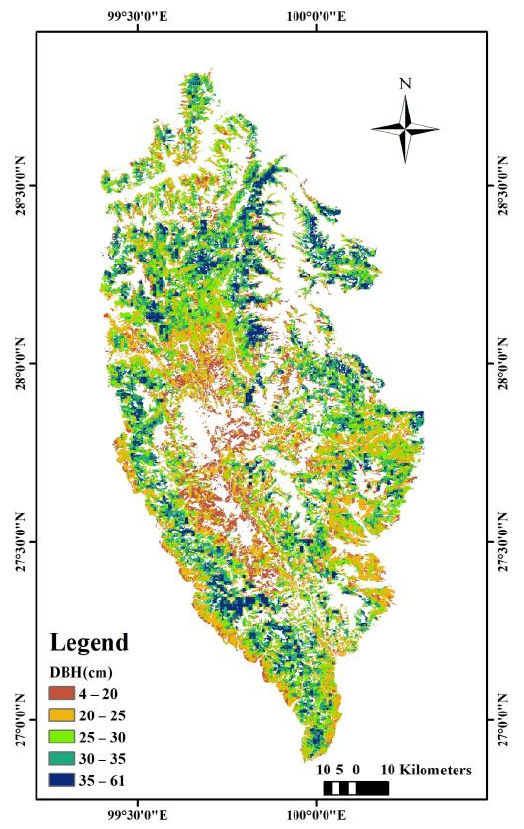
Figure 9. Forest DBH mapping in Shangri-La City.